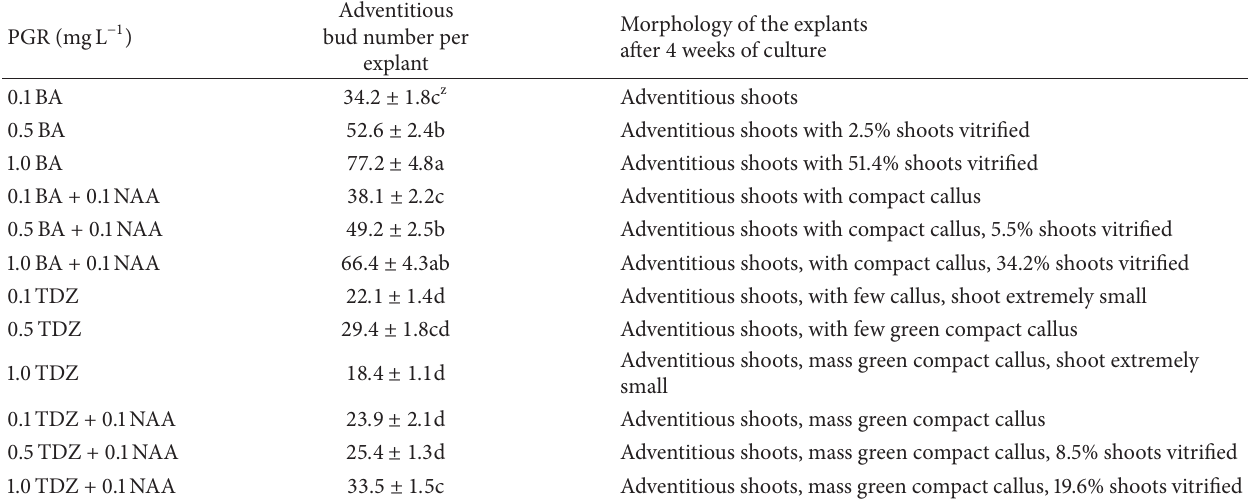
Table 2: Effects of PGRs on adventitious shoot proliferation in L. serratus.